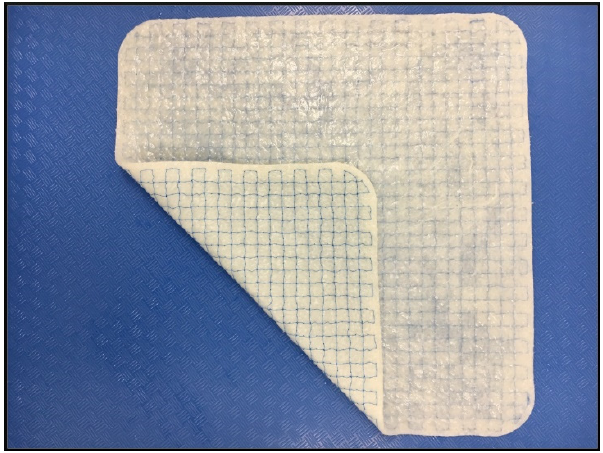
Figure 1. Photograph of OviTex 1S Permanent